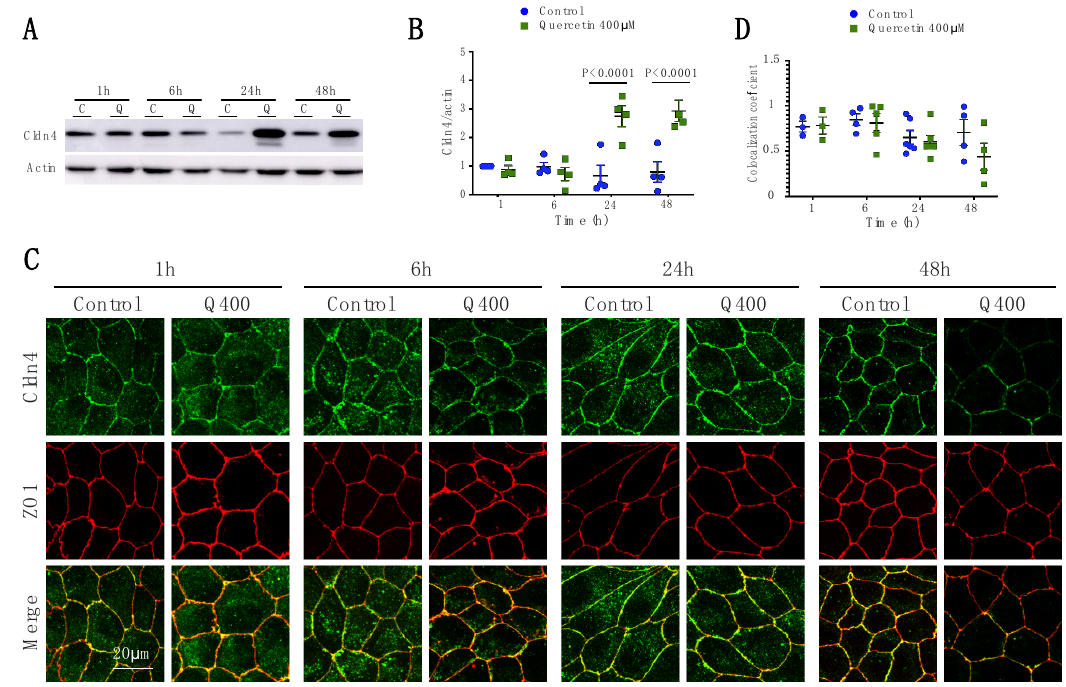
Figure 5. Analysis of Cldn4 expression and localization in MDCK II cells following quercetin treatment. ( A ) Western blot analysis of Cldn4 expression in cell lysates from control and 400 µ M quercetin-treated MDCK II cells. Actin was used as a loading control. ( B ) Densitometry measurements of Cldn4 and actin intensity on western blot were normalized to control levels at 1 h. Normalized Cldn4 expression relative to normalized actin is plotted (P int < 0.0001; P time = 0.0017; P treat < 0.0001). ( C ) Immunofluorescence of control and 400 µ M of quercetin-treated MDCK II cells at 1, 6, 24, and 48 h. Cldn4 is shown in green and ZO1 is shown in red. ( D ) Localization of claudin at the tight junction was assessed by determining the amount of ZO1 that co-localized with claudin expression (P int = 0.54; P time = 0.051; P treat = 0.24). For all graphs, each point corresponds to an independent experiment; mean and SEM are shown. C = Control and Q = Quercetin. Scale bar represent 20 µm.